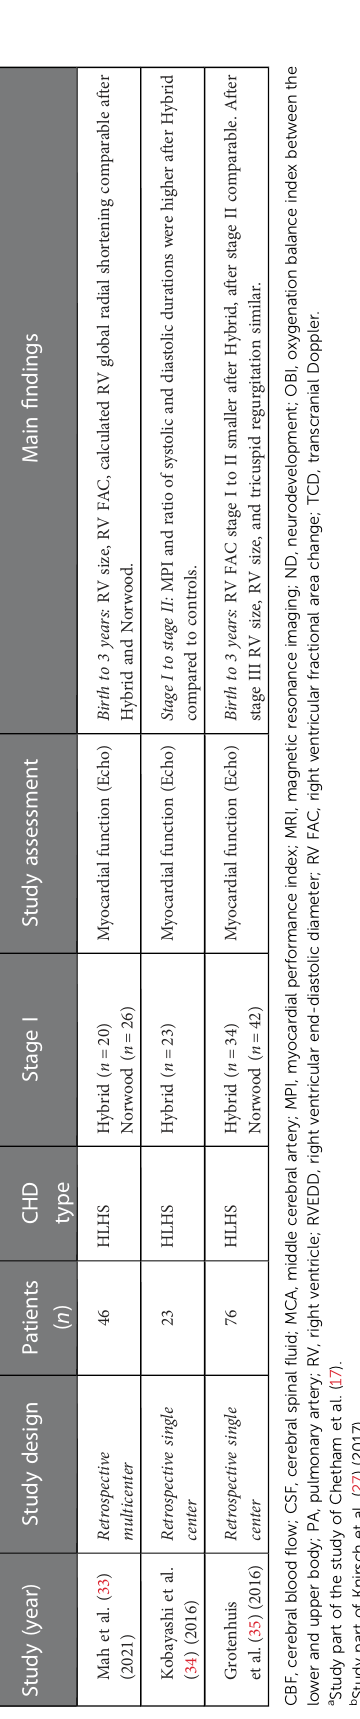
( Table 2 ) (17, 25 – 27). Transcranial Doppler cerebral blood fl ow (CBF) from the middle cerebral artery (17, 27) and cerebral MRI for assessment of brain volumes (26) showed lower CBF in infants (2 – 6 months of age) after Hybrid procedure as stage I compared to a control population (27), but showed no correlation with ND outcome at 6 months of age (17). Saiki et al. compared Doppler cerebral blood fl ow over a longer (chronic) time period between stage I and stage II with reduced oxygenation balance index between lower and upper body in patients after Hybrid procedure. While the total brain volume and total, deep gray, and white matter volumes were reduced in HLHS/C compared to controls at 2 – 3 years of age, the volume reduction of deep gray and white matter was more reduced after Norwood as stage I procedure compared to Hybrid procedure (26). Of note, r intracranial cerebral spinal fl uid volume was larger compared to e b e r healthy controls before stage III Fontan procedure and correlated AB with impaired ND outcome (25, 36). T